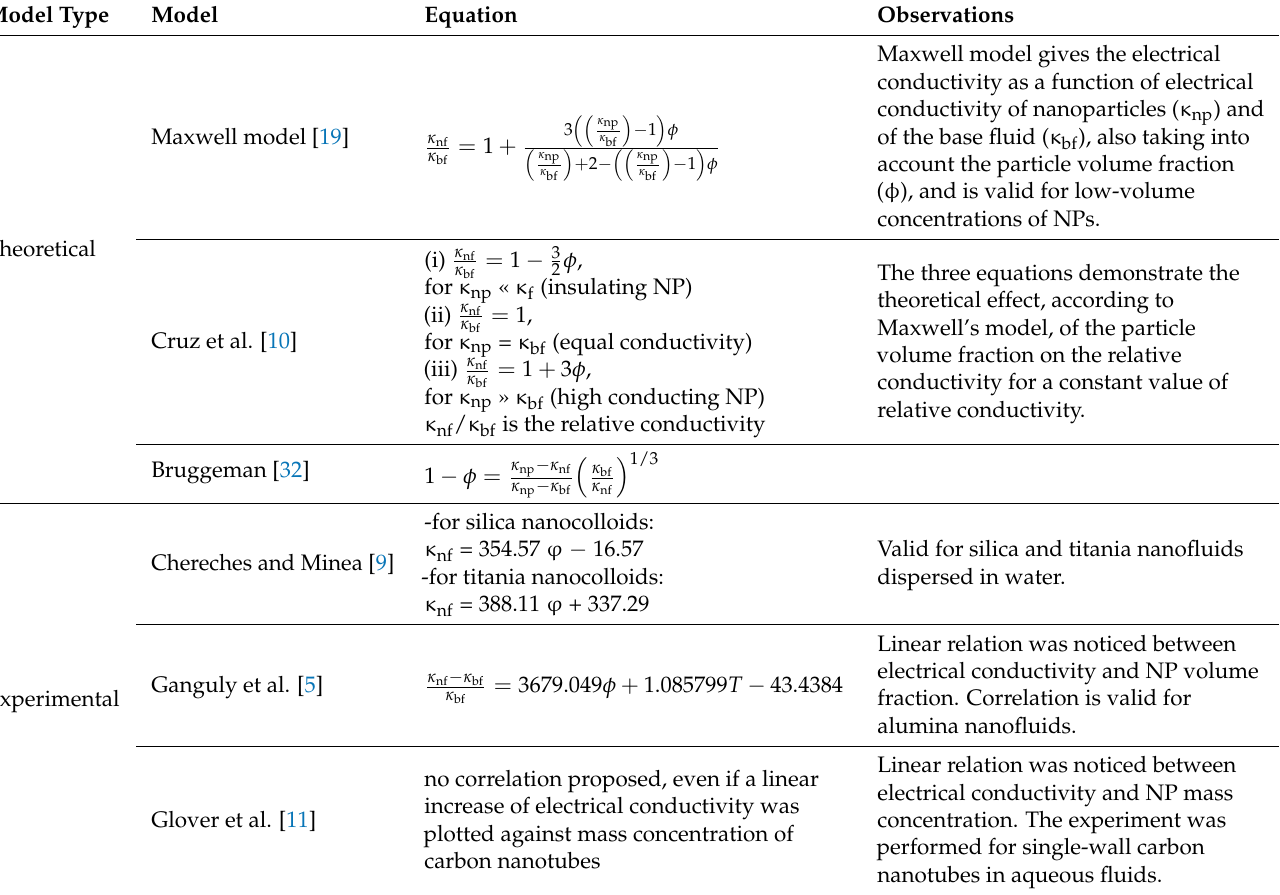
Table 1. Models for electrical